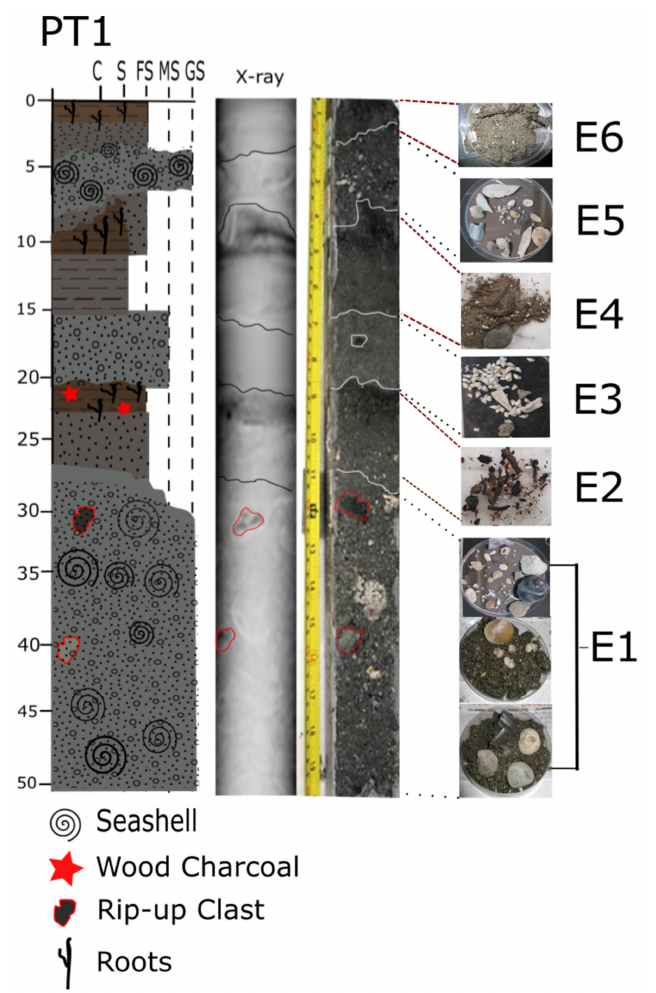
Figure 3. Lithologic diagram of PT1 core units (C: clay, S: silt, FS: fine sand, MS: medium sand, CS: coarse and very coarse sand), X-ray, photographic records of each lithologic unit and details of sediment composition in each deposit considered as events. Rip-up clasts are highlighted in unit 1 and wood charcoal fragments in units 2 and 4. Seashells are present in units 1, 3 and 5. The three other sediment deposits E2, E4 and E6 were composed of smaller grains, and according to the Munsell color scale, these fine sediments (medium grain size: 0.039–0.630 mm) were black (2.5Y 2.5/1) (Figure